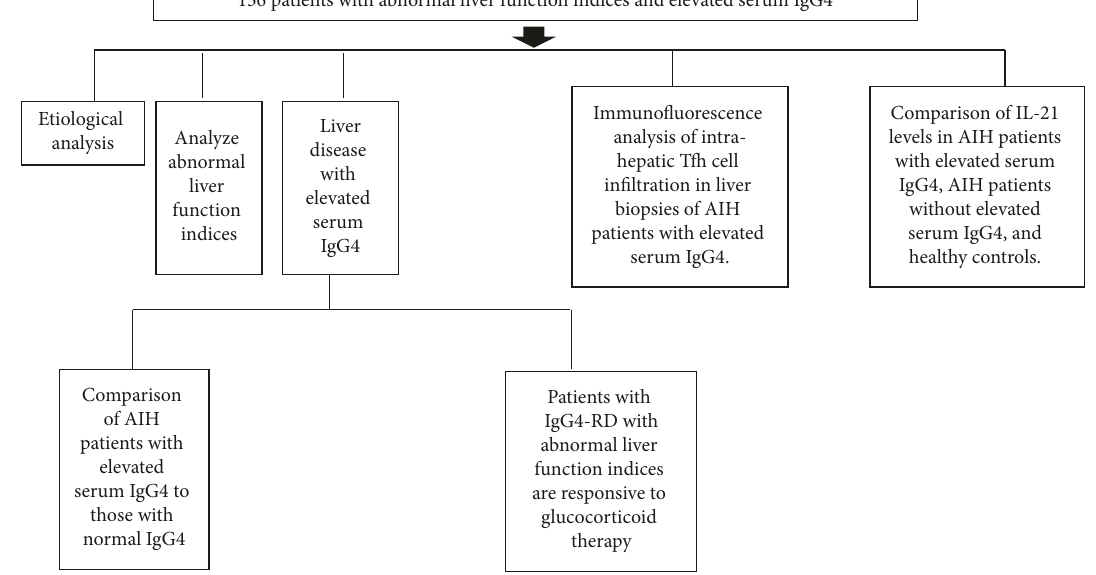
Figure 1: Flowchart depicting the patient enrollment and study